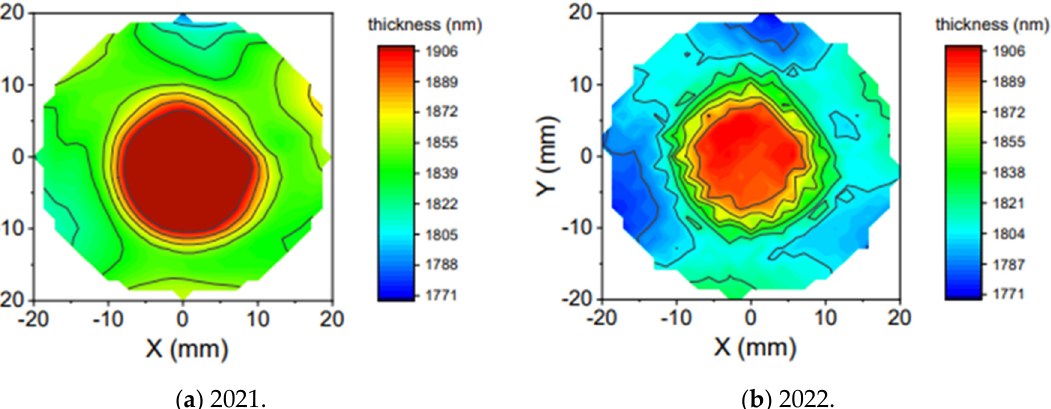
Figure 18. Maps of the same thin film (40 wt.% PDMS-based ormosil) at two different dates: ( a ) in 2021 and ( b ) in 2022. The sample was stored in a horizontal position.